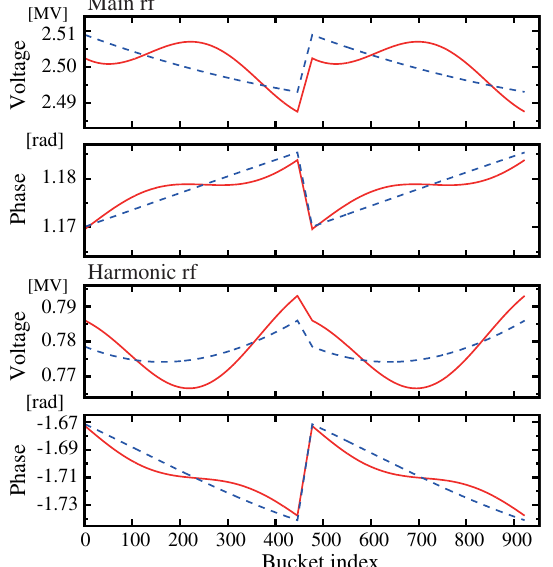
FIG. 10. Rf amplitudes and phases as a function of the bucket index. Solid and dashed lines indicate those with and without the compensation, respectively. The upper two and lower two graphs indicate the main and harmonic rf voltages, respectively.